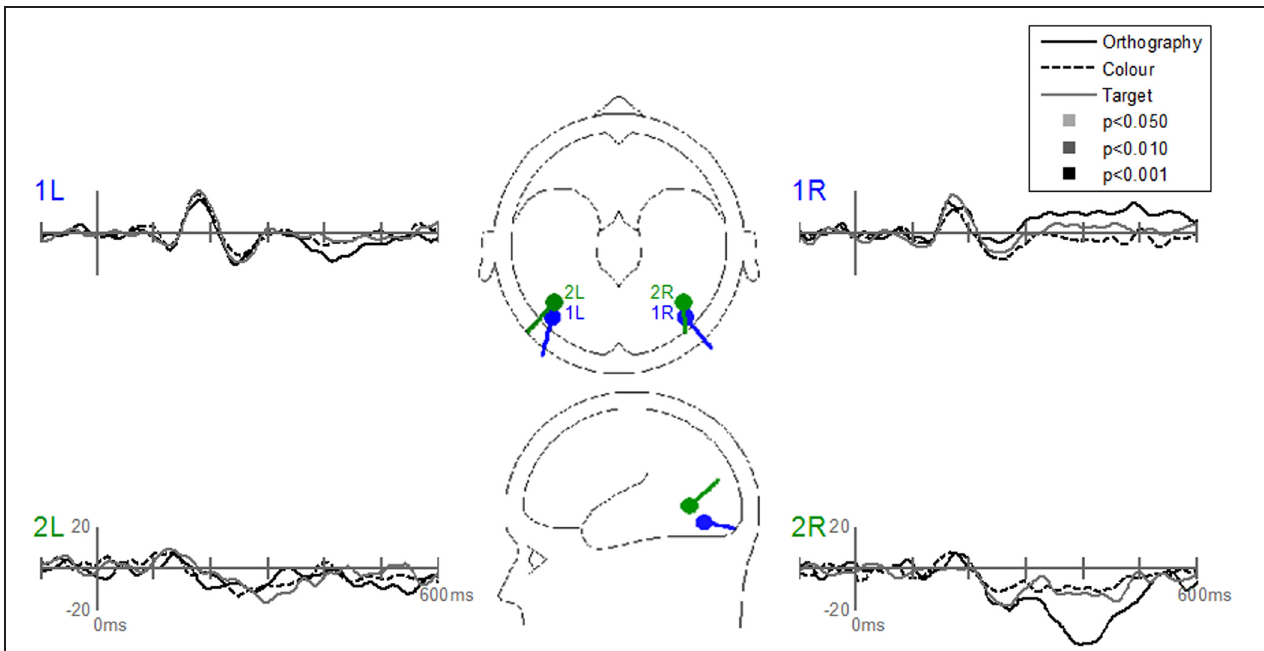
FIGURE 9 | Grand-mean source waveforms for the Interaction of Task by Stimulus for the Stimulus-effects model (inset) with bilateral dipoles in the fusiform gyri (dipoles 1L and 1R) and bilateral inferior temporal gyri (dipoles 2L and 2R). Waveforms are plotted as the differences between